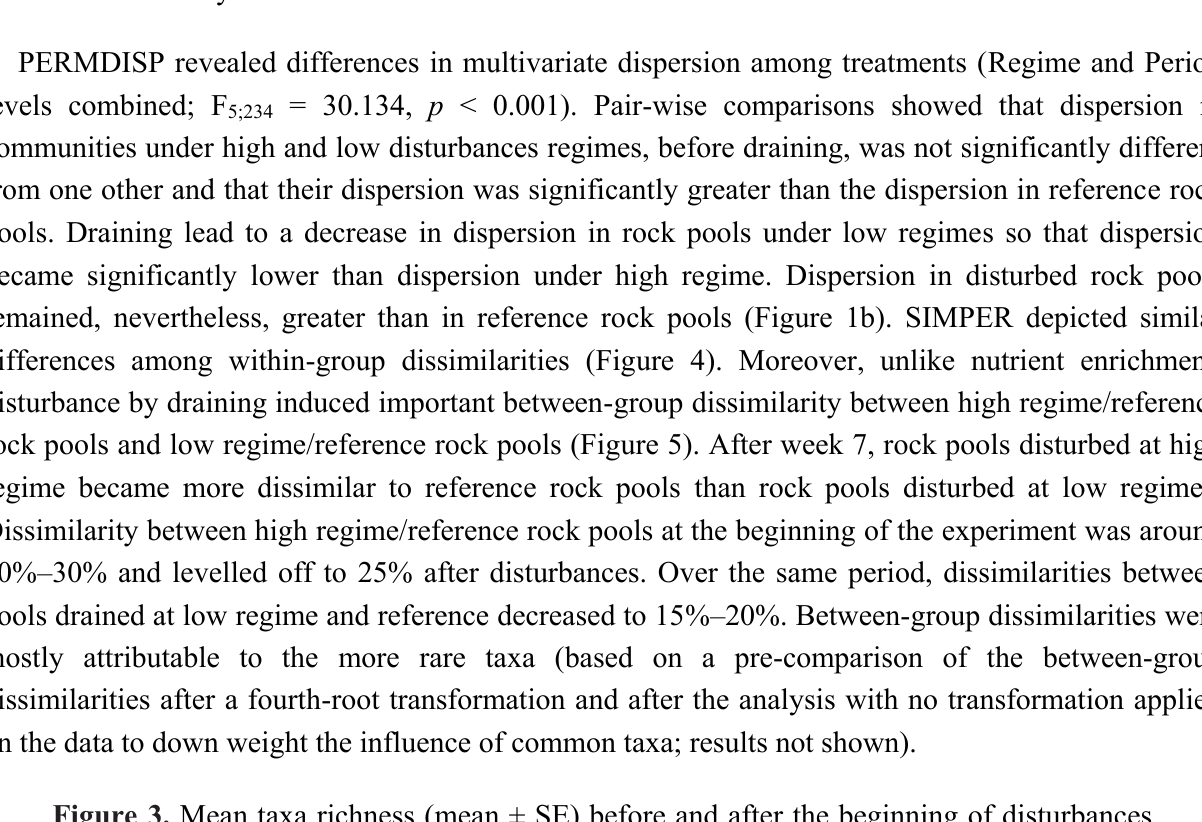
Figure 3. Mean taxa richness (mean ± SE) before and after the beginning of disturbances by draining. Before = black; After = cyan; High = nutrients added every diurnal low tide; Low = nutrients added six times during the period; Reference = no nutrient added. Different letters indicate statistically significant difference between